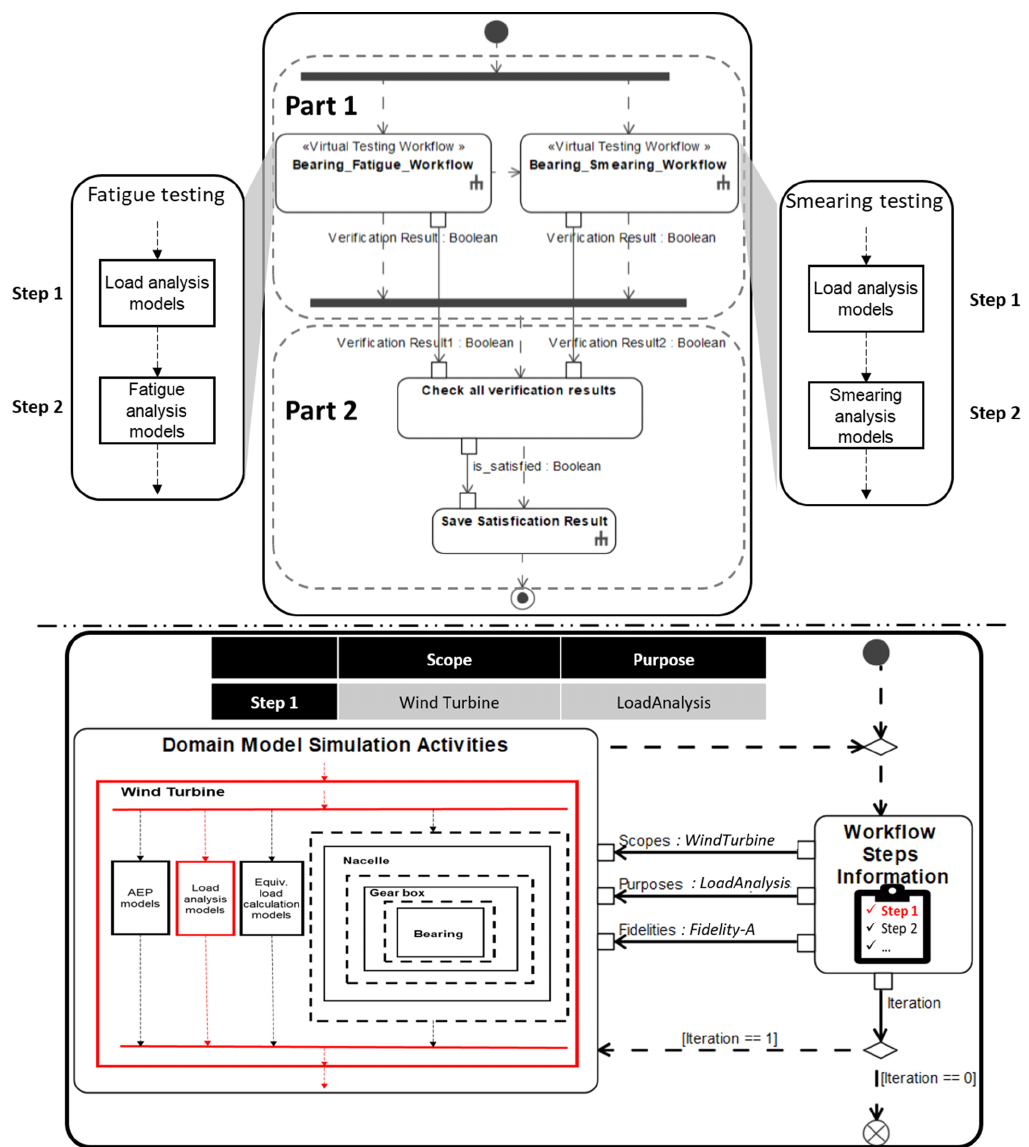
Figure 9. Execution of the simulation activities in the workflow through an iterative loop.